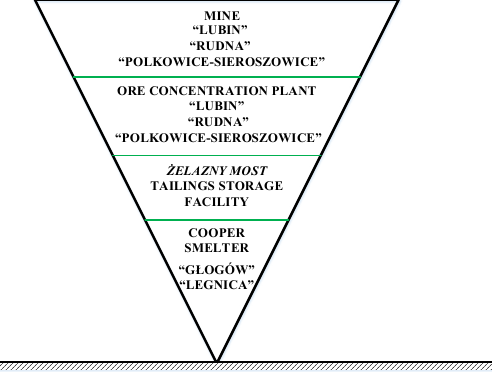
Figure 1: Location of OUOW Żelazny Most within the system of the critical infrastructure of LGOM (source: own